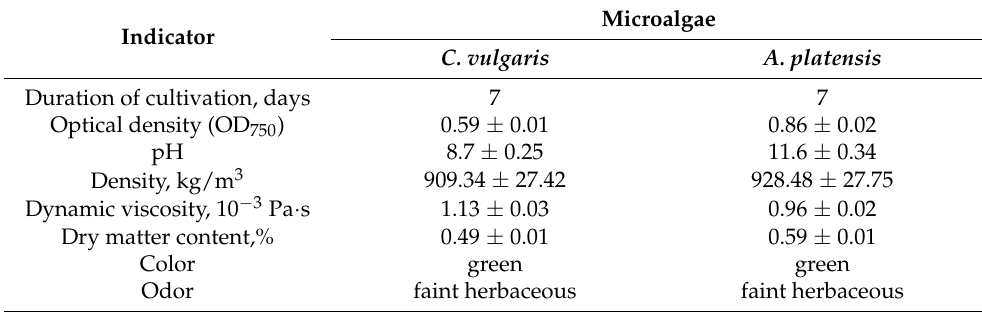
Table 1. Physicochemical properties of microalgae samples.